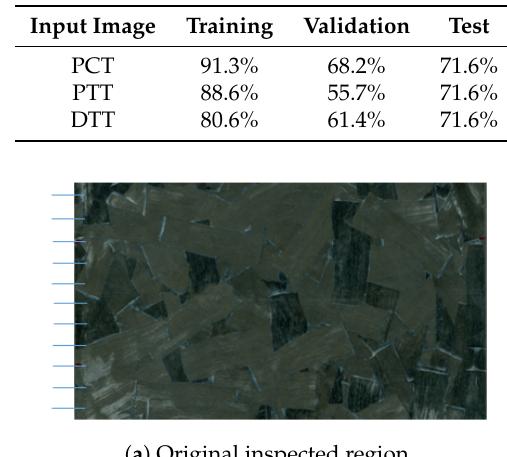
Table 1. ANN classification rates.